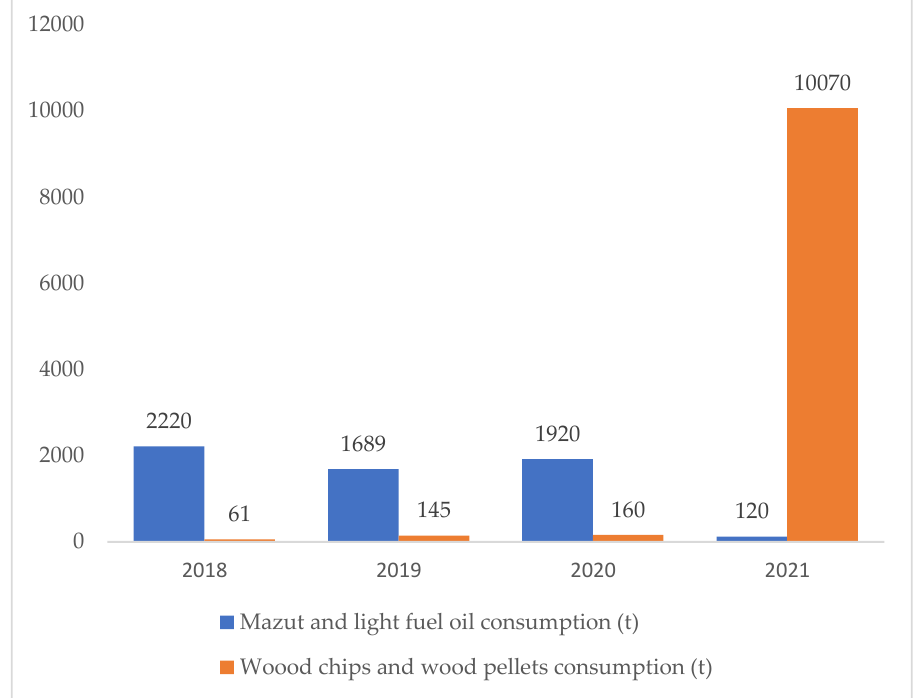
Figure 9. Consumption of selected fuels in the district heating system in Priboj [108,165 – 167]. However, the achievement is facing new barriers that are located beyond the reach of the local level. While local resource availability in the form of residual wood is docu-